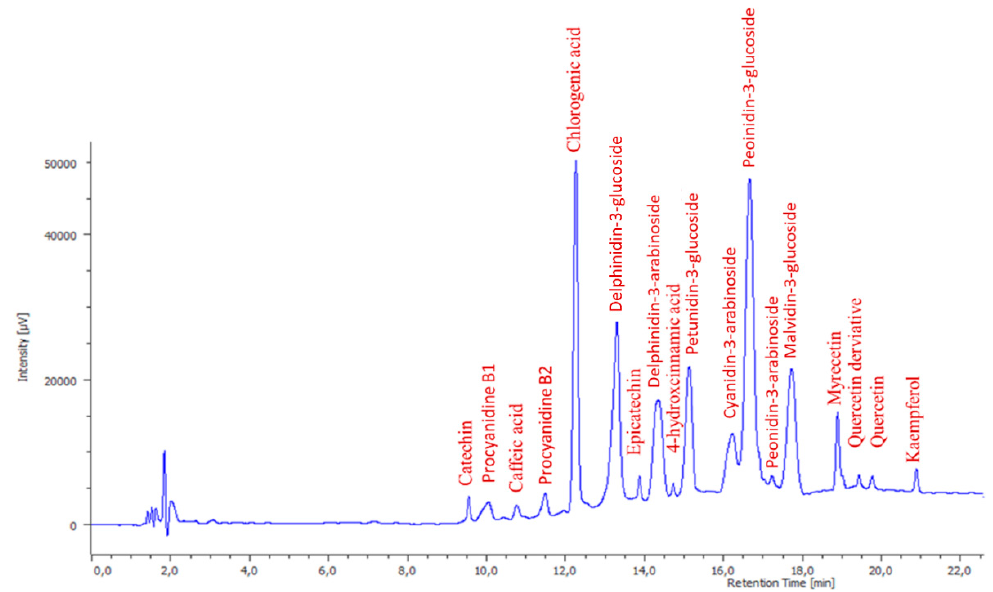
Figure 2. High-Performance Liquid Chromatography with the Diode-Array Detector (HPLC-DAD) chromatogram (280 nm) obtained for a blueberry pomace sample.